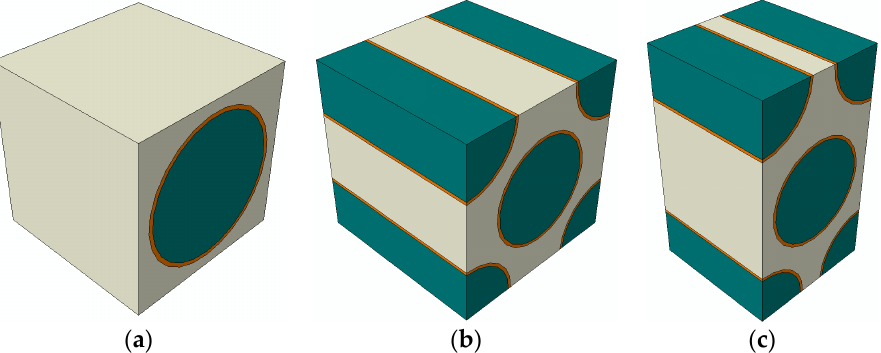
Figure 8. ( a ) Single-fiber unit cell (RVE-1), ( b ) RVE with rectangular fiber placement (RVE-2), and ( c ) RVE with hexagonal fiber placement (RVE-3).